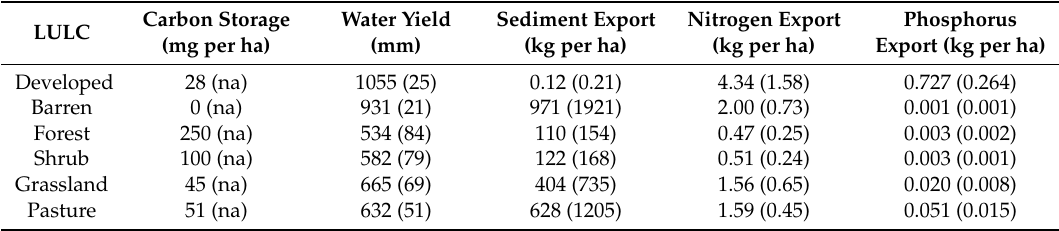
Table 4. Mean production values of the five biophysical indicators of the ecosystem service by each land cover type under the 2011 LULC scenario. The standard deviation values are presented in the parenthesis after the mean production values.